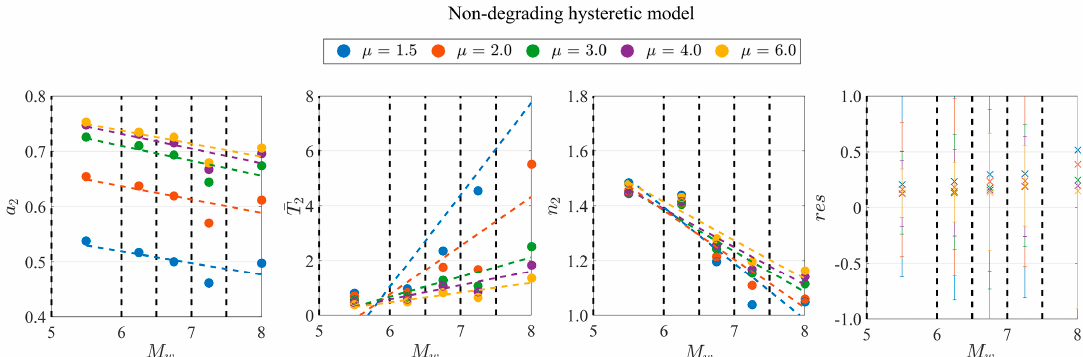
Figure 14. Constants involved in the regression analysis of the mean spectra of the hysteretic energy reduction factor R Ha for hysteretic non-degrading behaviors (dots: regression results; line: proposed closed-form relationship), together with the regression error chart.